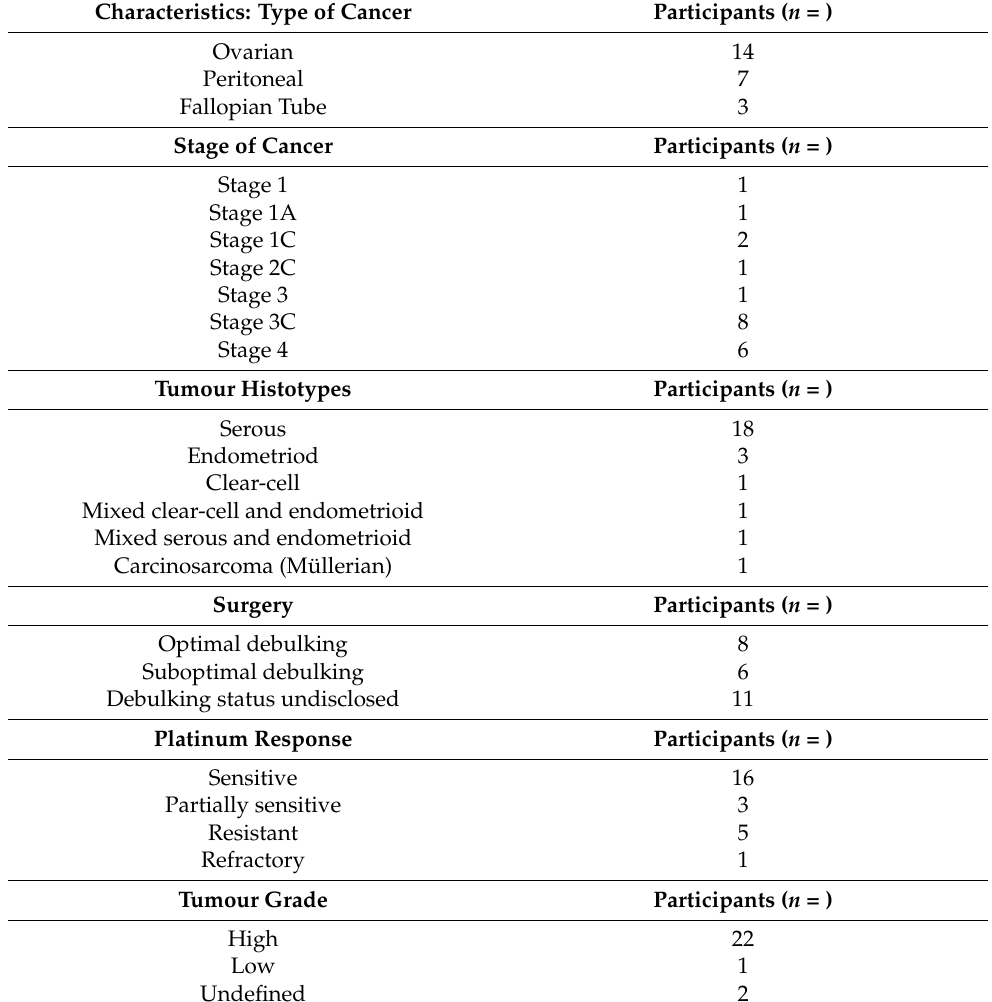
Table 3. Tumour characteristics: tumour stage, grade, histotype, surgery and platinum response in study